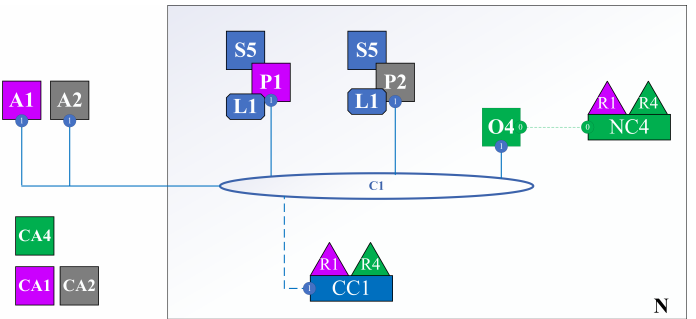
Figure 1. Hyperledger Fabric